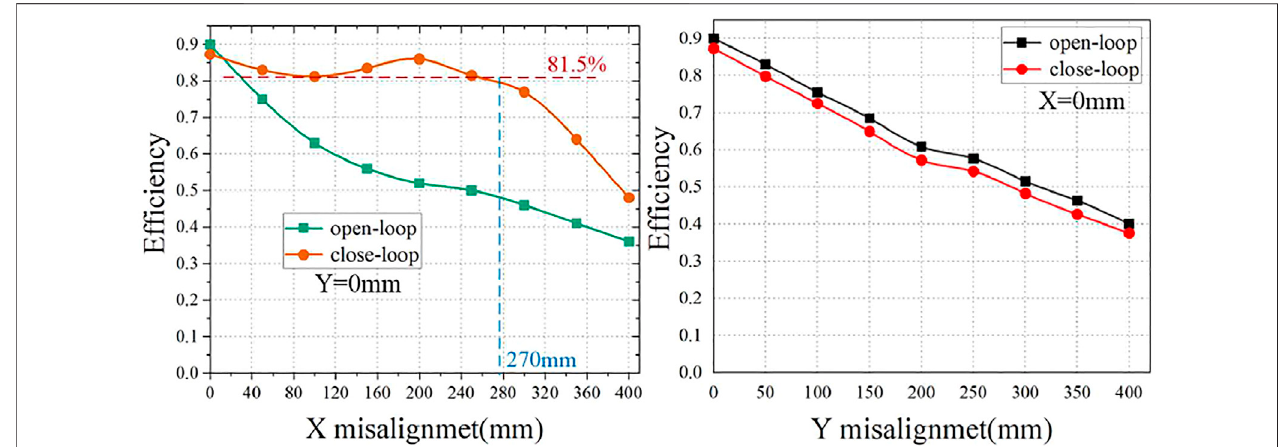
FIGURE 20 | Design of the modular WPT